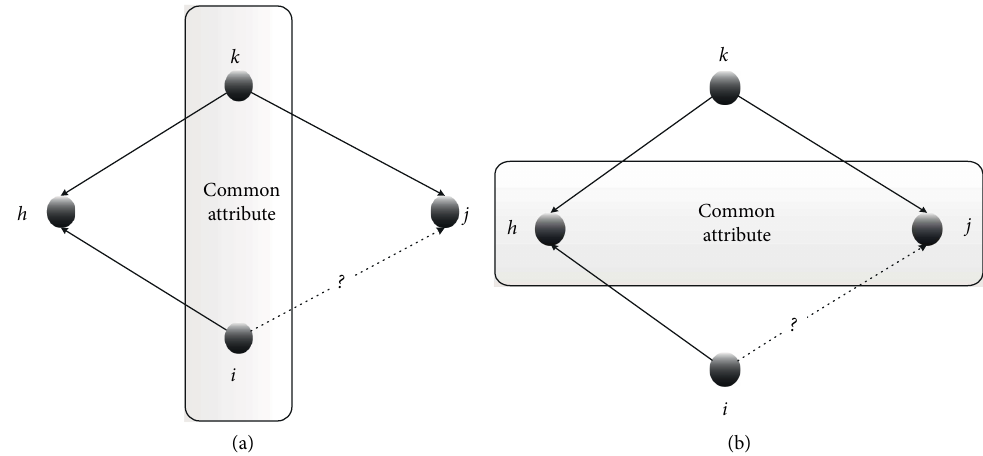
Figure 1: Similarity diagram. (a) The out node pair. (b) The in node